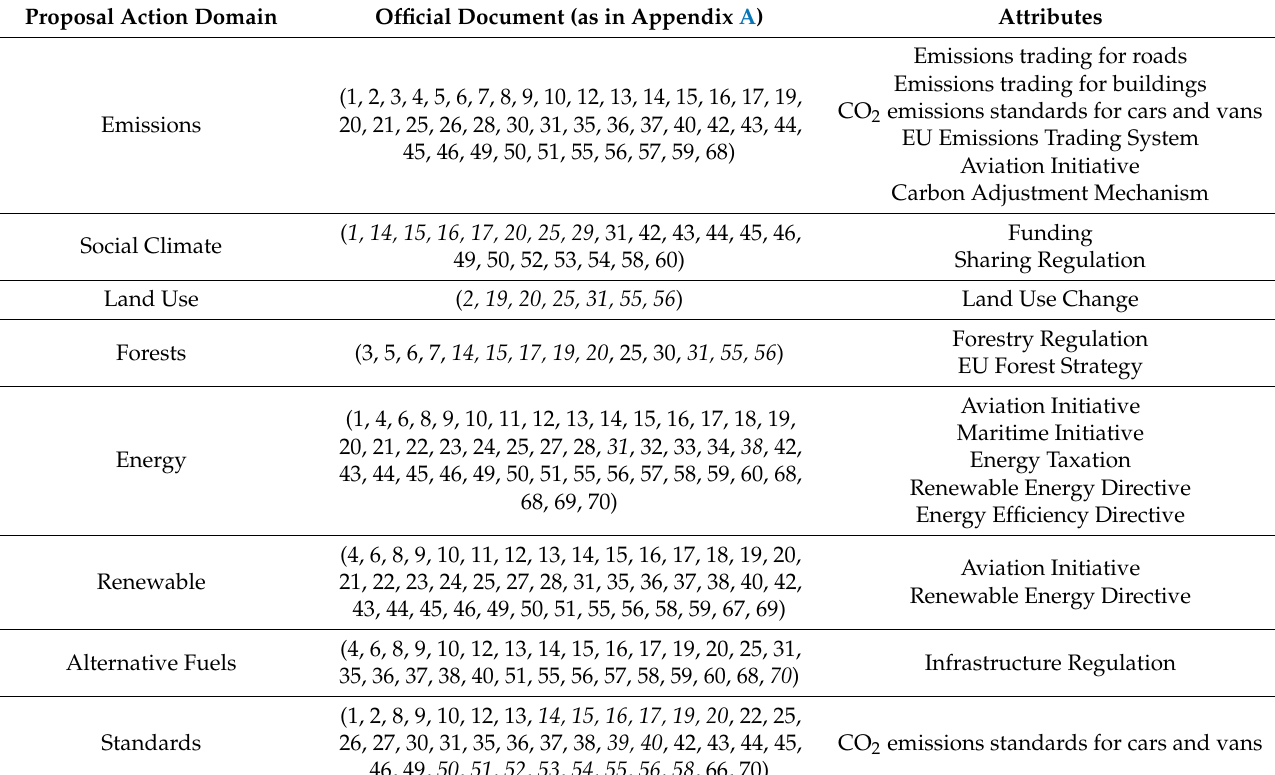
Table 1. Targeted actions as identified in 70 official documents issued by European regulatory bodies (Appendix